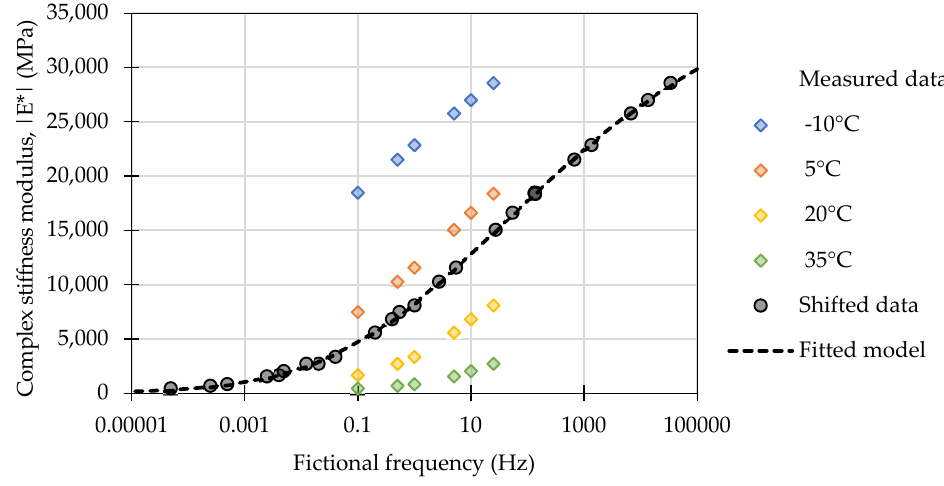
Figure 3. The principle of shifting the measured values of the complex stiffness moduli in the frequency domain to construct a master curve.